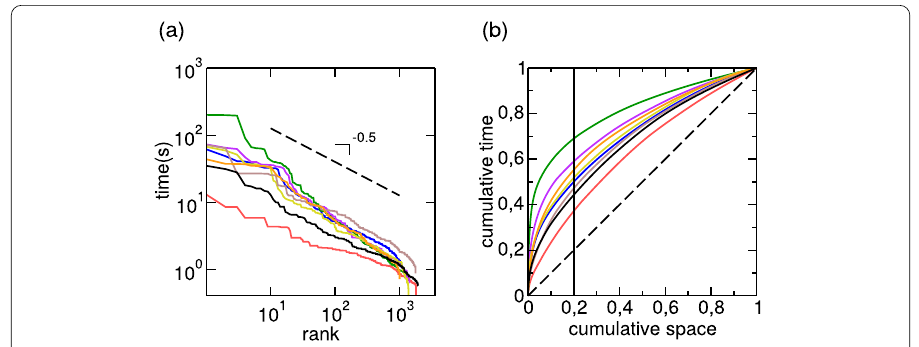
Figure 3 Zipf and Lorenz curve of some trips. ( a ) Zipf plots of several trips of different bus routes. The Zipf plot is constructed by sorting decreasingly the values of (cid:2) t ∗ . The values of (cid:2) t ∗ are obtained dividing the course of each trip into constant spaces of (cid:2) s ∗ = 10 m. Thus, in ( a ), the y -axis corresponds to the values (cid:2) t ∗ and the x -axis is the rank of each (cid:2) t ∗ both in logarithmic scale. It has ranking 1 the highest value (cid:2) t ∗ , ranking 2 the second highest value (cid:2) t ∗ and so on. The Zipf plot shows a pervasive fat-tail characteristic for the interpolated time values (cid:2) t ∗ , where the dashed line corresponds to the line with slope equals –0.5 in log–log space. ( b ) The Lorenz curves L ( s ) of the trips shown in ( a ), where each color represents the same trip. The equality line E ( s ) is shown as a dashed line and is used to calculate the Gini coefficient values for each trip, namely, being twice the area between E ( s ) and L ( s ). Each curve gives a Gini coefficient, one for each trip, representing the heterogeneity of the interpolated times. The continuous vertical line indicates where the 80/20 ratio of the Pareto Principle occurs